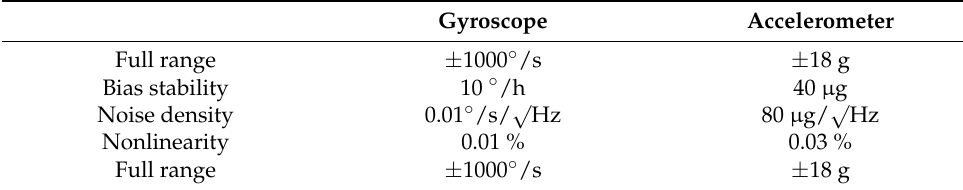
Table 1. Performance parameters of the inertial sensor.